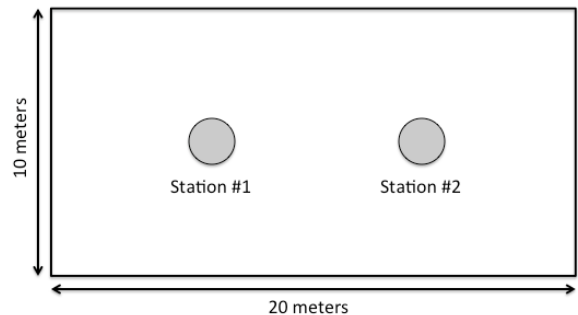
Figure 1: Schematic of Static Geometric Calibration Collection Set-up